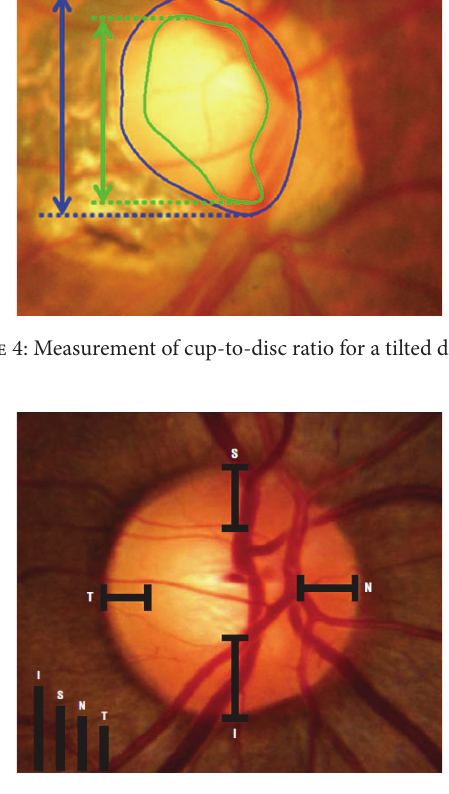
Figure 5: Measurement of the ISNT rule